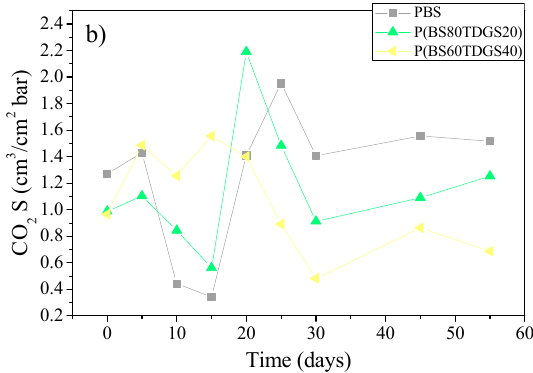
Figure 4. D coefficients for PBS and P(BSxTDGSy) copolymers after: ( a ) thermal ageing (at 40 °C, 50% RH, air ventilated); ( b ) photo-ageing at 23 °C, D65 Neon light, 50% RH, air ventilated.